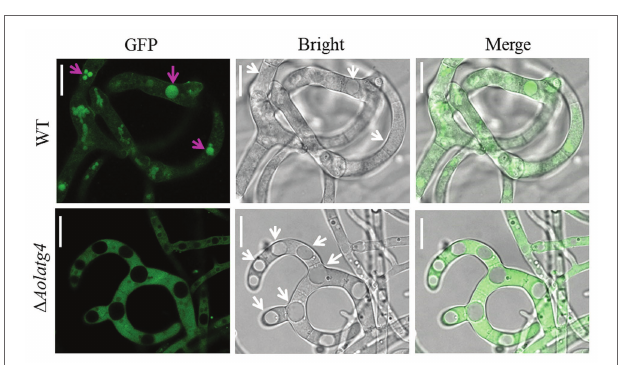
FIGURE 5 | Detection of autophagosomes in the traps of the WT and ∆ Aolatg4 mutants. Conidial suspensions of the indicated strains were inoculated on MM-N plate contained cellophane. After 24-h incubation at 28 ° C, about 100 nematodes were added on each plate. Autophagosomes in traps were observed using fluorescence microscopy. White arrow: vacuoles; red arrow: autophagosomes. Scale bars = 10 μ